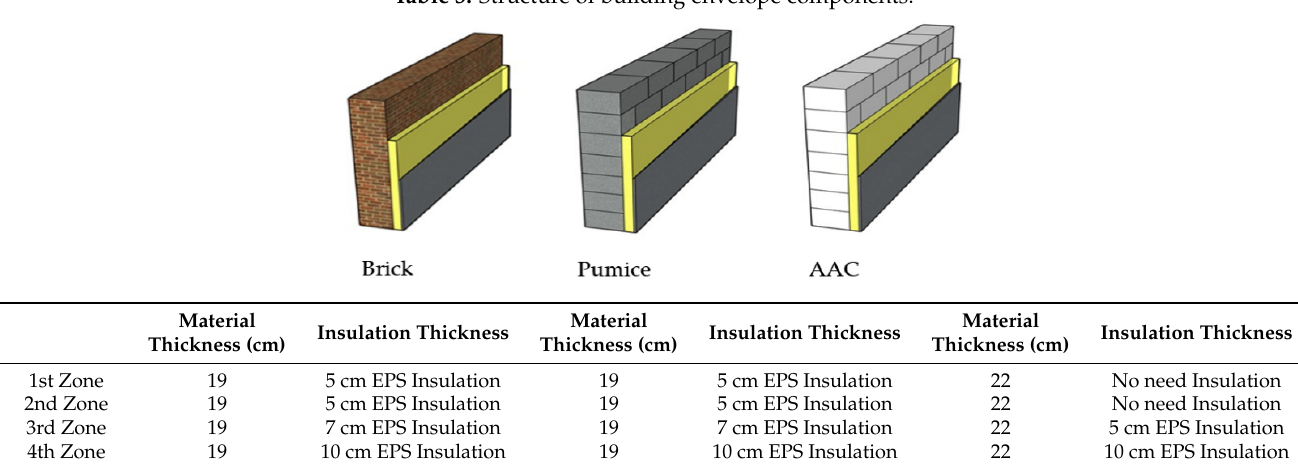
Table 3. Structure of building envelope components.